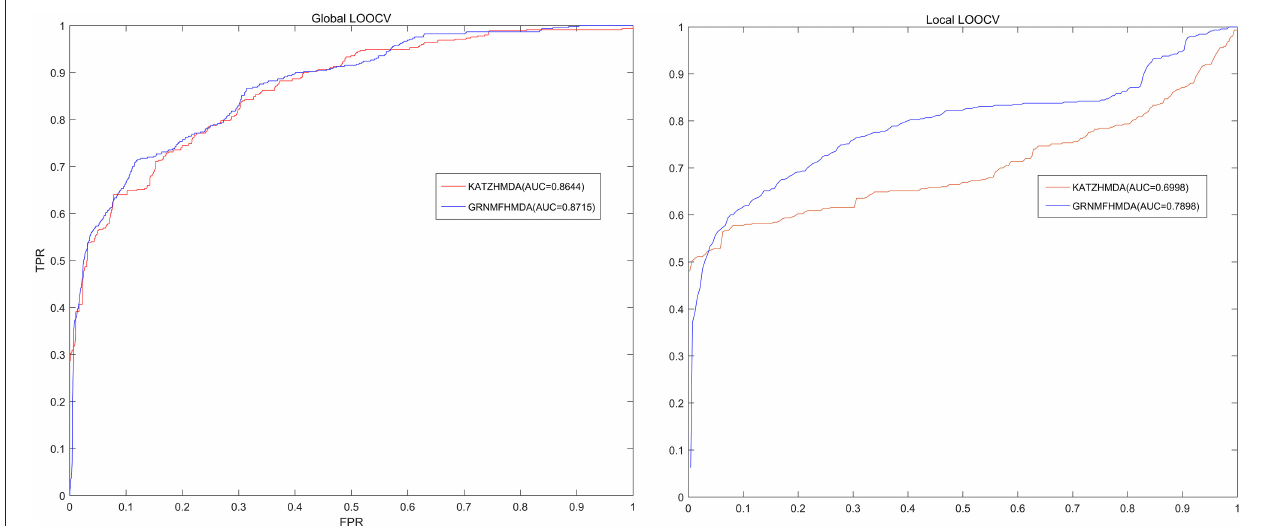
FIGURE 3 | The comparison of prediction performance between GRNMFHMDA and the classical model of KATZHMDA both in global LOOCV and local LOOCV. As a result, GRNMFHMDA achieved AUCs of 0.8715 and 0.7898 in the global and local LOOCV, which exceed the first computational model of KATZHMDA in the field of microbe-disease association prediction.